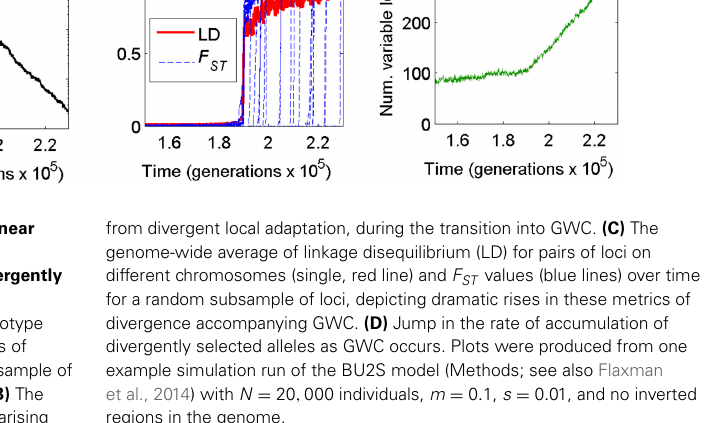
FIGURE 1 | Genome wide congealing can cause dramatic, nonlinear shifts in (A) local adaptation, (B) effective migration, (C) linkage disequilibrium and F ST , and (D) the rate of accumulation of divergently selected mutations. (A) Average fitness of residents (orange) and immigrants (purple) over time relative to a randomly assembled genotype (yellow), depicting the rapid transition from genic to genomic phases of population divergence as GWC occurs. Gray dots are a random subsample of individual fitness values (200 individuals per generation sampled). (B) The effective migration rate, m e , as a measure of reproductive isolation arising